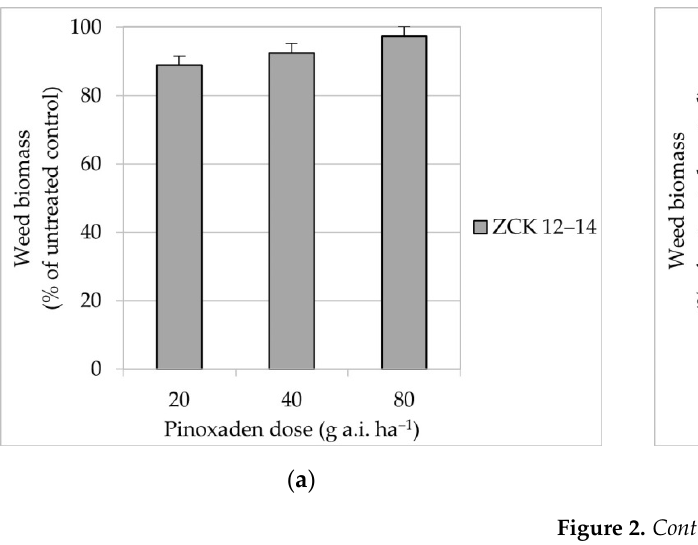
Figure 1. Visual injuries (% of untreated control) of A. myosuroides at 7 ( a ), 14 ( b ) and 21 ( c ) days after treatment (DAT) with various pinoxaden doses at different growth stages. Vertical lines indicate a statistical difference according to Fisher’s Least Significant Difference (LSD) test at p < 0.05. LSD ( a ) = 3.02; LSD ( b ) = 4.45; LSD ( c ) = 5.14. Greenhouse experiment had four replicates with